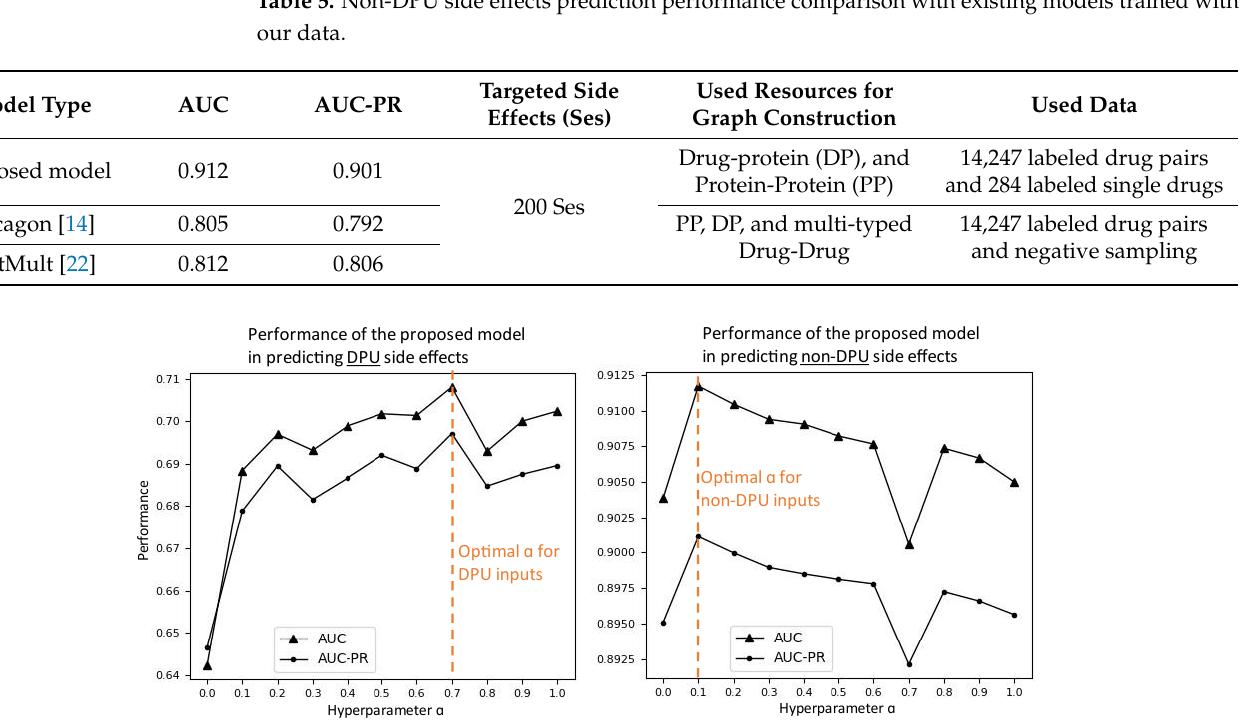
Figure 3. Polypharmacy side effects prediction performance under different choices of the hyperpa- rameter ɑ .